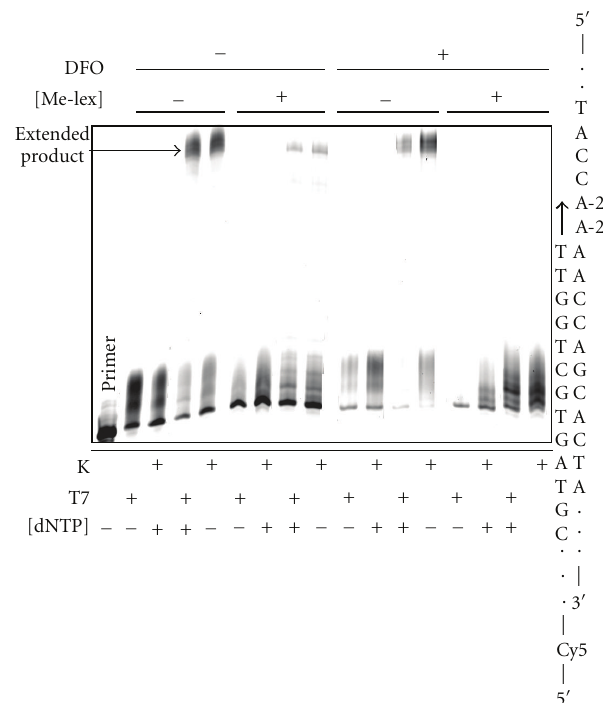
Figure 4: Insertion opposite and extension from 3-mA by T7 Sequenase (T7) and Klenow fragment (K) (exo − ) polymerases. The template strand in the absence ( − ) or presence (+) of the DFO was treated with 0 or 2.5 mM Me-lex as described in Figure 1. A 5 (cid:2) -labeled primer (Table 1, P25) was used that overlaps with the two 3 (cid:2) -A’s (A-24, A-25) that are not significantly methylated by Me-lex (Figure 1). T7 Sequenase (T7) or Klenow polymerase exo − (K) was added and the reaction initiated by the addition of the four dNTPs (0 or 500 μ M) to determine insertion opposite, and extension from, 3-mA at 37 ◦ C. The production of extended product is reduced with Me-lex treatment in the presence of the DFO.